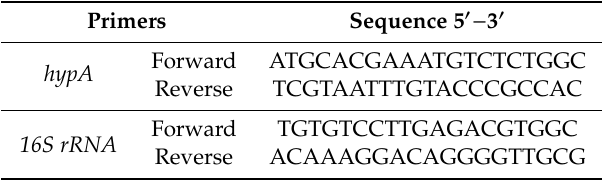
Table 1. Oligonucleotides used in this study for transcriptional analysis.